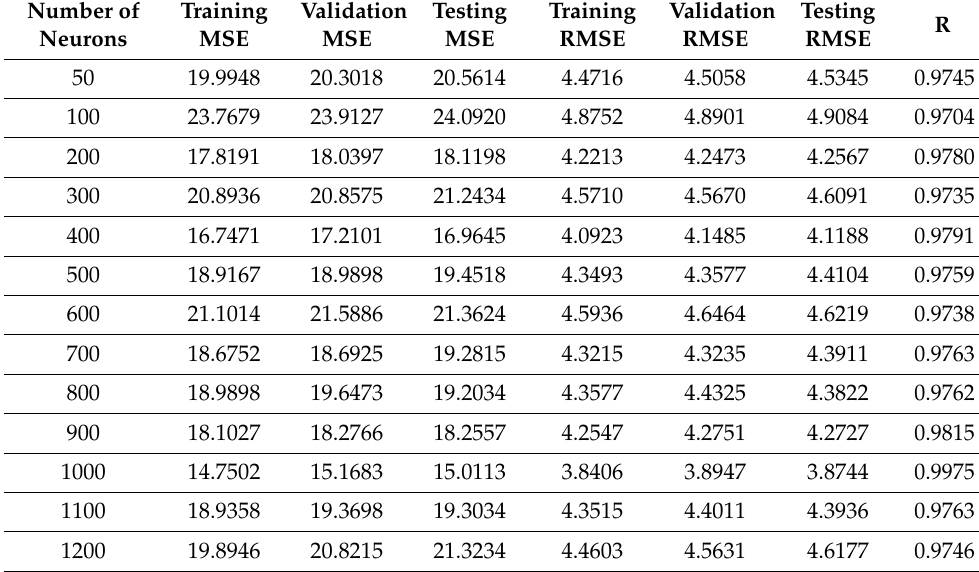
Table 4. The MSE, RMSE, and R values when training the NFS model using the SCG